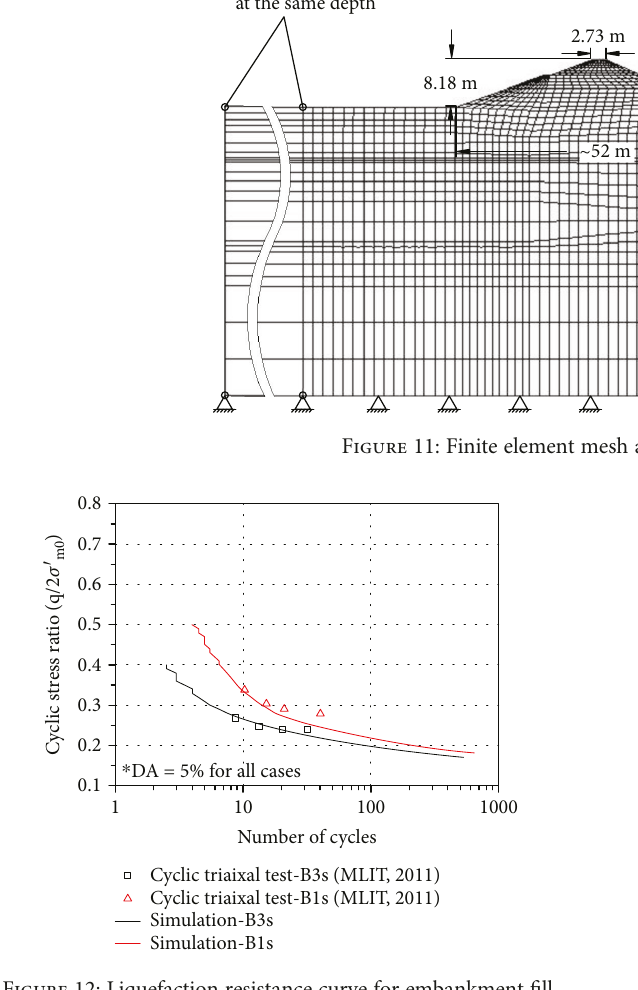
Figure 12: Liquefaction resistance curve for embankment fi ll.